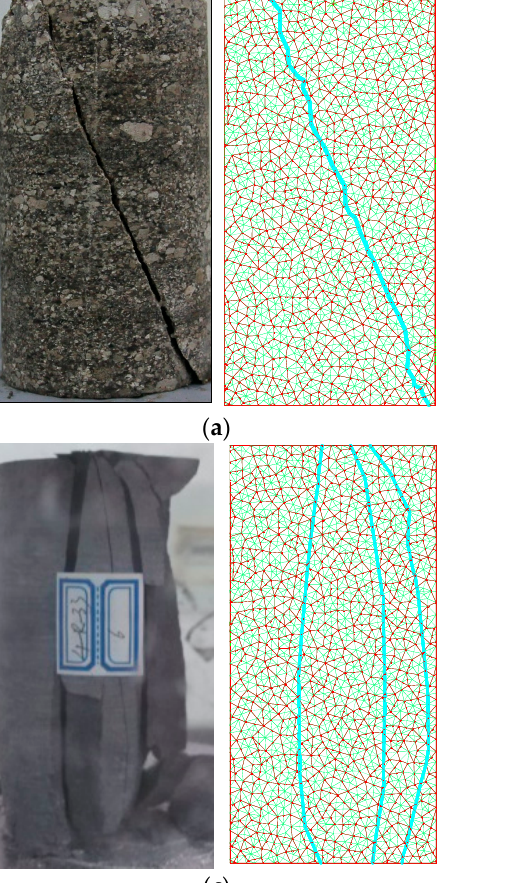
Figure 12. Seepage calculation model based on the experimental typical failure form: ( a ) type I; ( b ) type II; ( c ) type III; and ( d ) type Y.